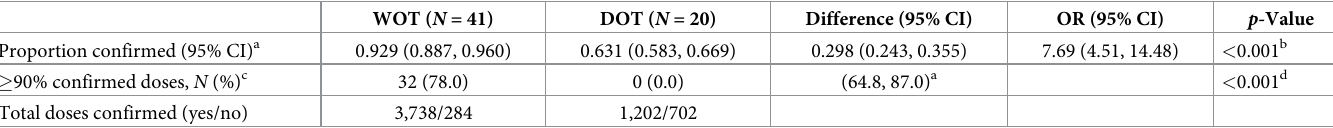
Table 3. Proportion of confirmed doses, WOT versus DOT. ITT analysis. Confirmed dose defined as 1 or more tablets detected or witnessed. WOT ( N = 41) DOT ( N = 20) Difference (95% CI) OR (95% CI) p